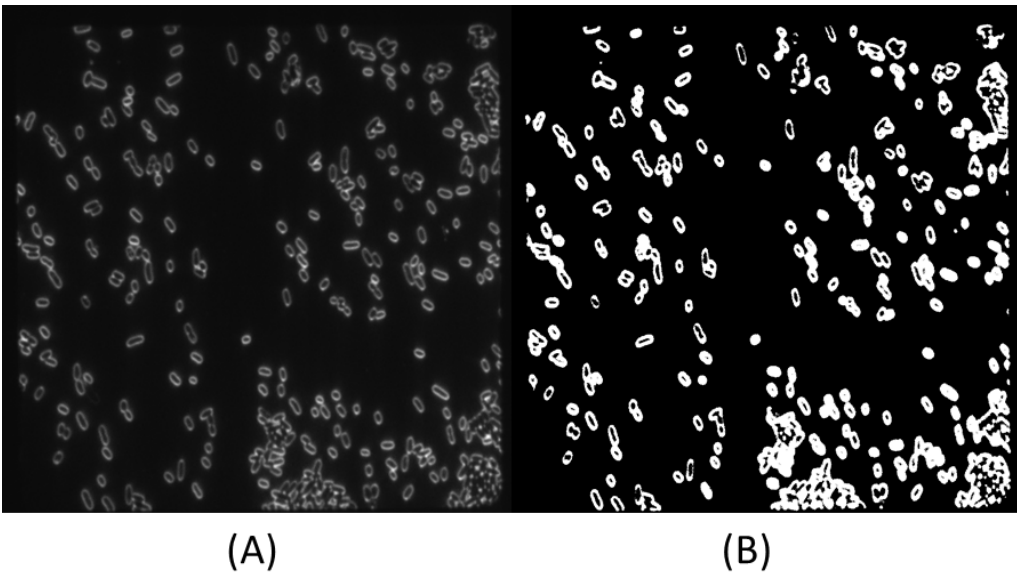
Figure 3. Hyperspectral microscope image of Salmonella Heidelberg at 638 nm: ( A ) Raw image and ( B ) cell segmentation image with extracted pixels shown in white.